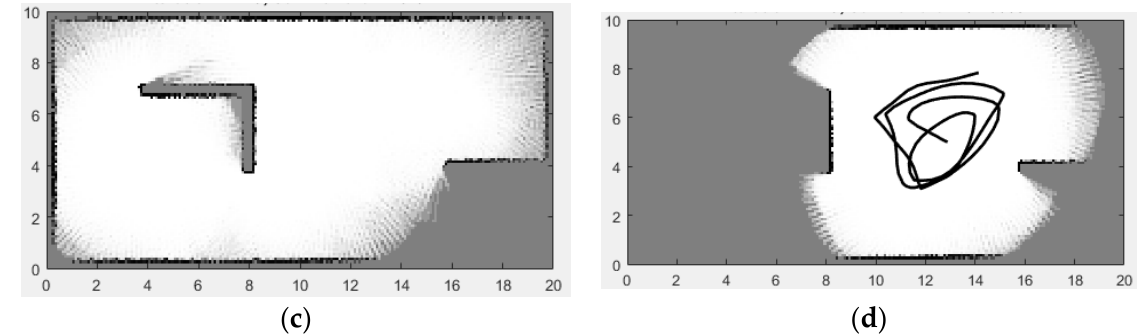
Figure 10. The mapping results of the DDPG agent in the custom environments. ( a ) Map coverage: 99%, Initial positions: x = 6, y = 4. ( b ) Total reward ( 𝐺 ): 90, Initial positions: x = 6, y = 4. The black line is the robot trajectory. ( c ) Map coverage: 86%, Initial positions: x = 13, y = 5. ( d ) Total reward ( 𝐺 ): 67, Initial positions: x = 13, y = 5. The black line is the robot trajectory.